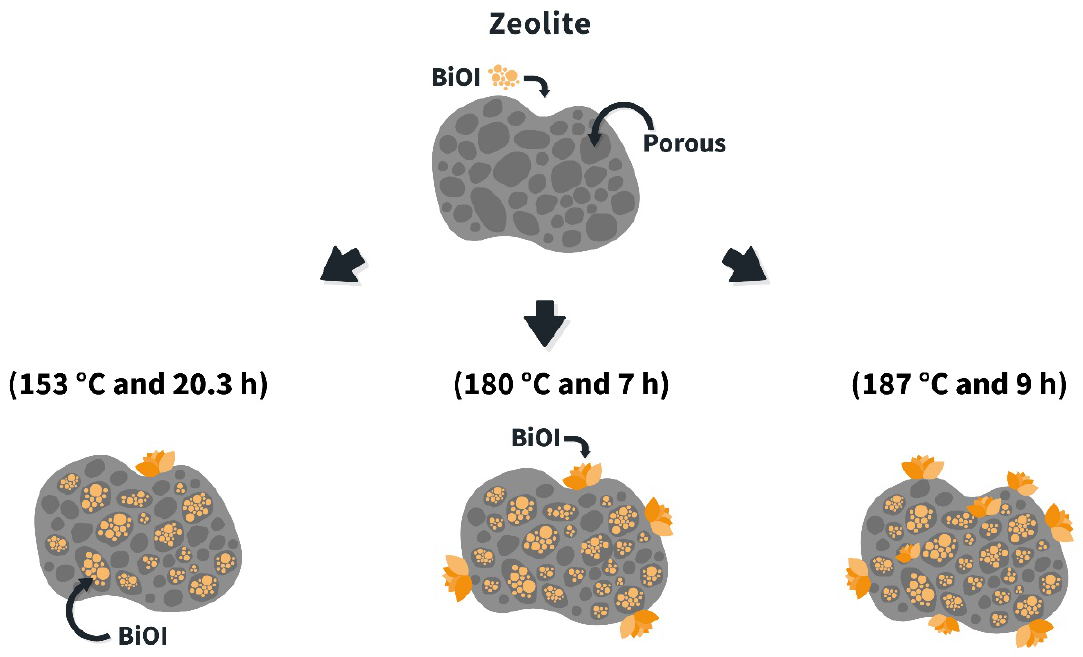
Figure 9. Schematic representations of BiOI/mordenite composite formation.